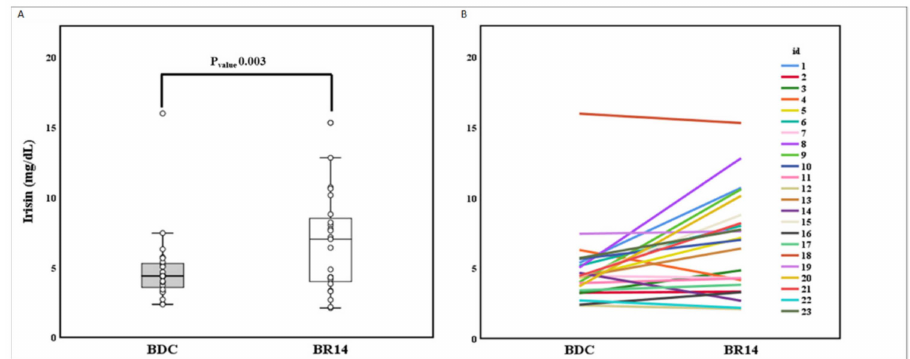
Figure 1. Effect of 14-day Bed Rest on irisin. ( A ): t -test pairs between BDC and BR14 irisin. ( B ): Spaghetti plot of irisin trend between BDC and BR14. BDC, baseline data collection; BR14, after 14-day Bed Rest data